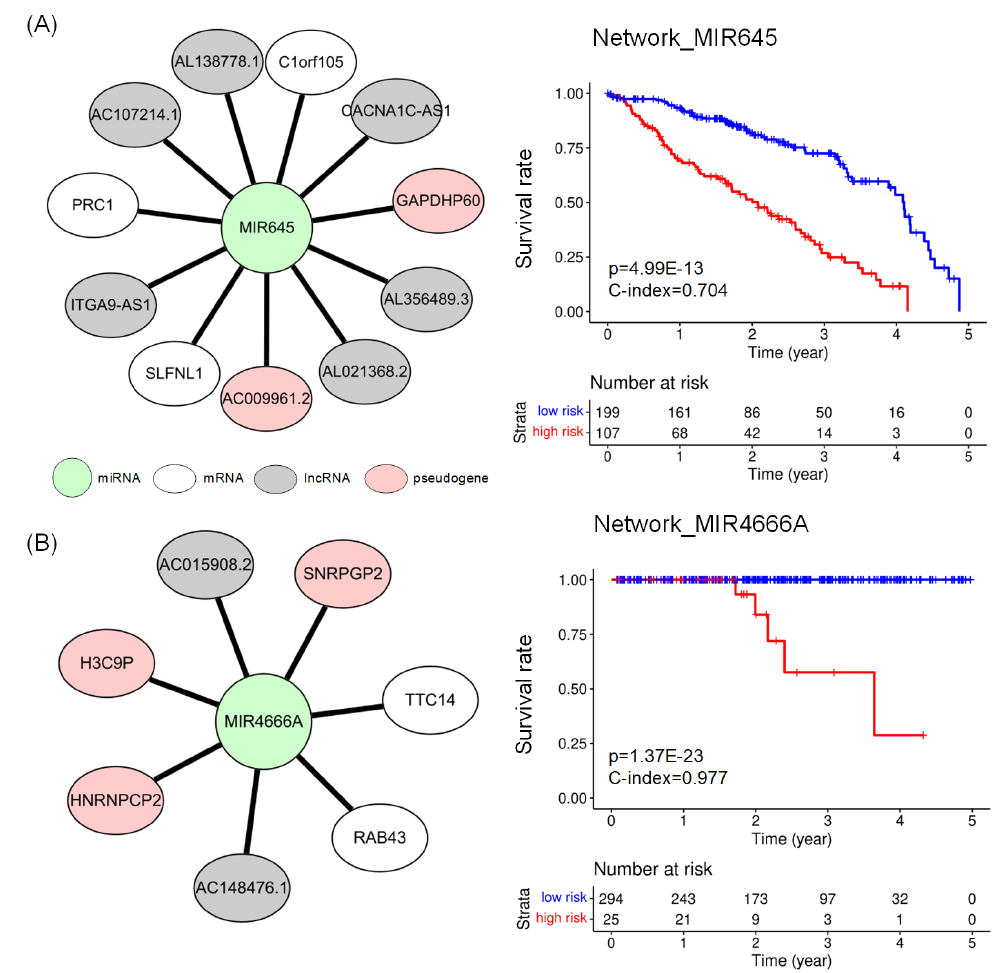
Figure 3. ( A ) Network_MIR645 for prognosis of LUAD, which consists of 3 mRNAs (white ellipse), 6 lncRNAs (grey ellipse), and 2 pseudogenes (pink ellipse) connected to 1 miRNA (shown as green circle). ( B ) Network_MIR4666A for prognosis of PRAD. It consists of 2 mRNAs, 2 lncRNAs, and 3 pseudogenes connected with miRNA. The Kaplan–Meier plots compare the survival rates of two groups of risk scores, which were defined using Equation